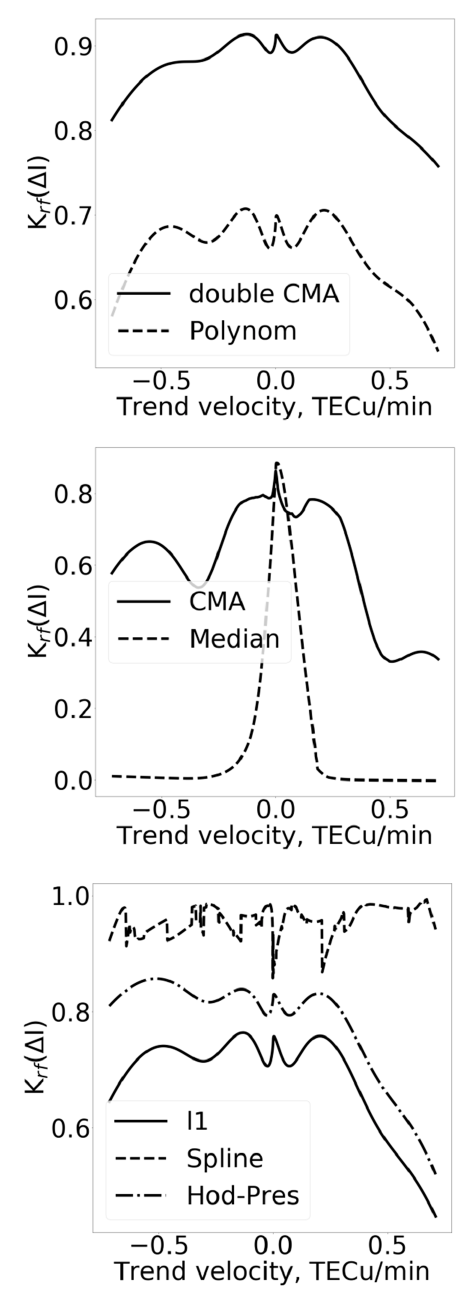
Figure 6. Trend velocity vs. the correlation coefficient.